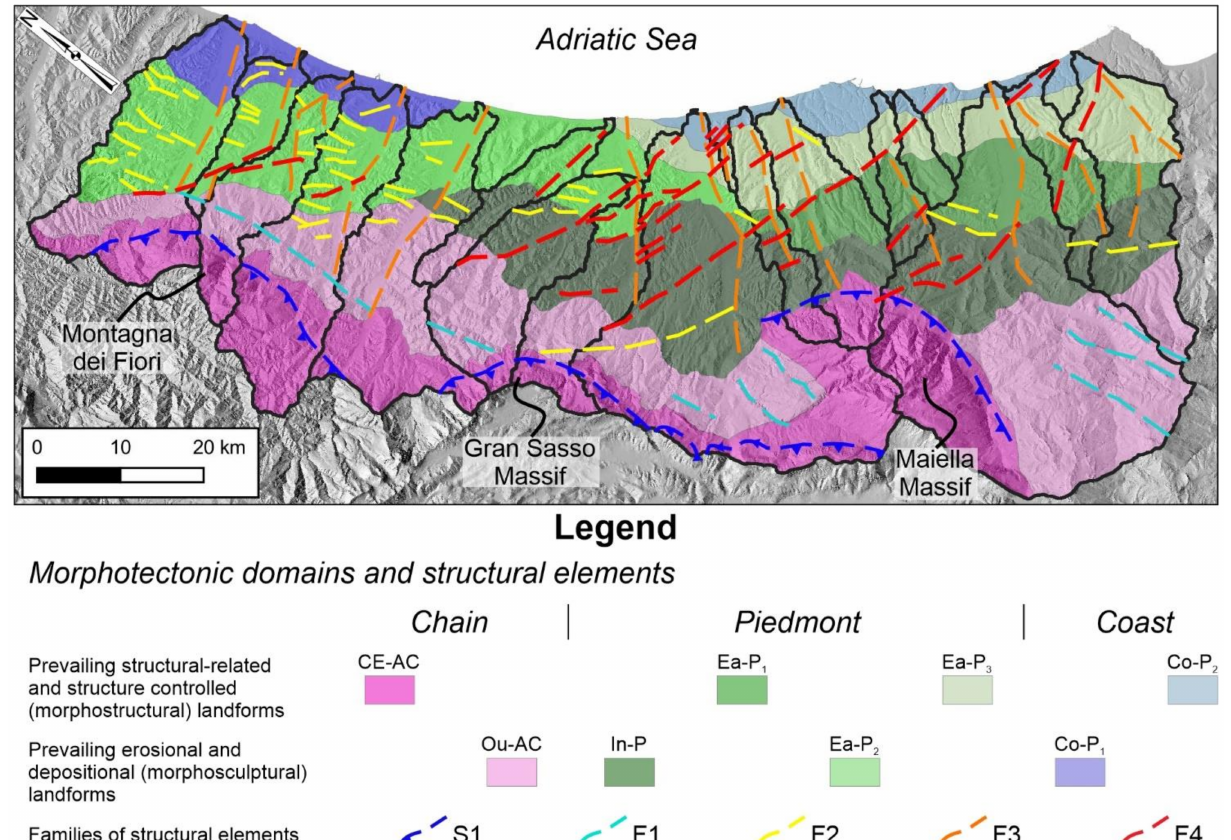
Figure 11. Morphotectonic domains and structural elements of the Abruzzo Periadriatic Area. Black lines represent the watershed of the main 16 basins analyzed. Note: S1—compressive thrusts; F1, F2, and F3—normal fault systems; F4—transtensive fault